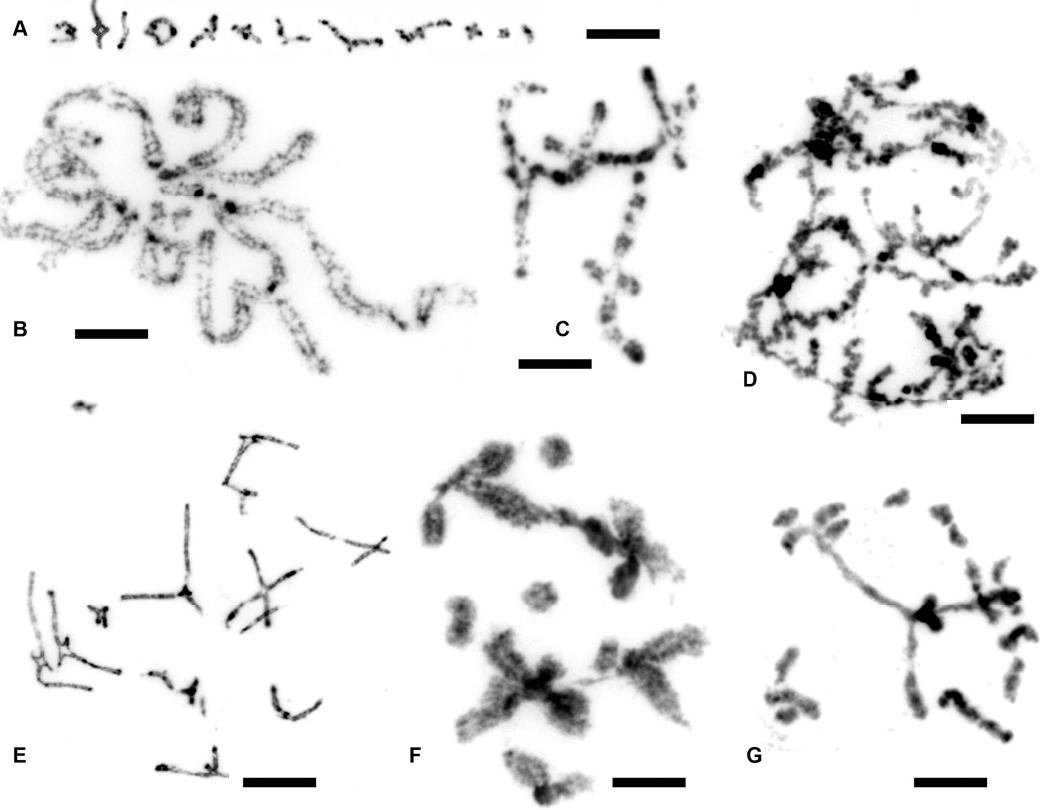
Figure 7. Meiosis in E. virens and other asexual species. ( A ) E. virens , Spain, Laguna Caracuel, a sexual female showing 12 bivalents; ( B ) E. virens , Spain, Almodovar, a probably asexual diploid female; ( C ) E. virens , Italy, Sicily, a sexual female, chromosomes chained into a single formation; ( D ) Bradleystrandesia fuscata , Germany, Gauting, an asexual female, meiotic chromosomes resembling “lampbrush” chromosomes; ( E ) E. virens , Italy, Sicily, a sexual female; ( F ) E. virens , Italy, Rivalazzetto, an triploid asexual female; ( G ) H. incongruens , Germany, Martinsried, an asexual female. Chromosome preparations were stained with DAPI and inverted. Scale bar indicates 5 µm.